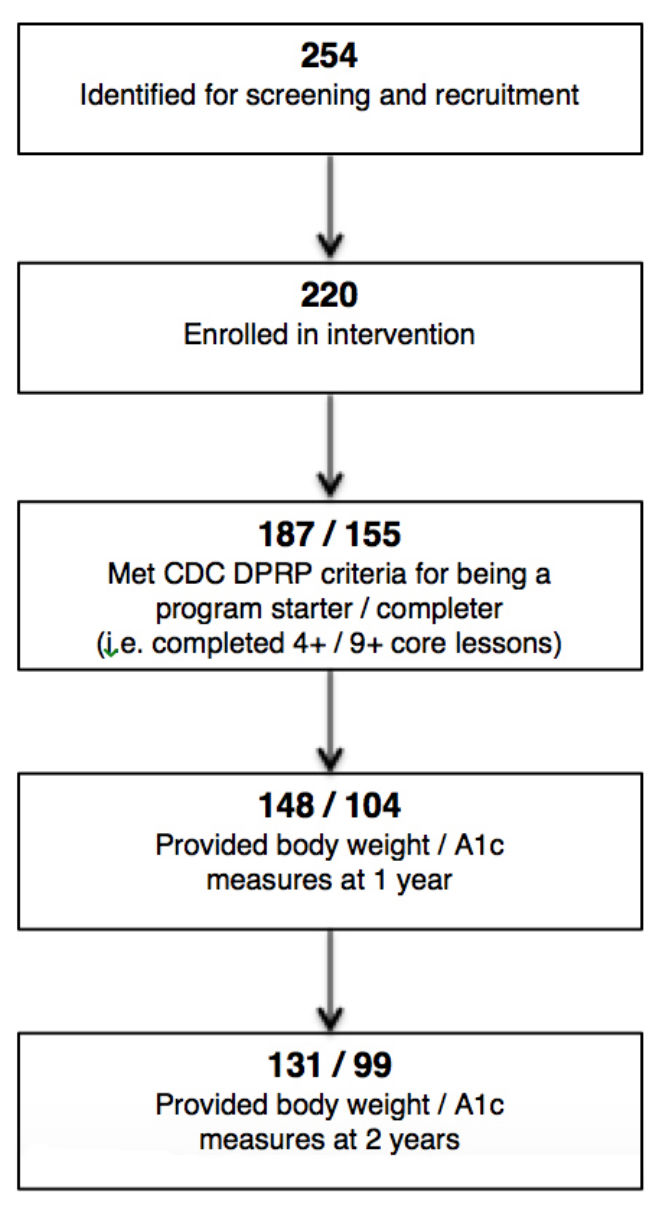
Figure 1. Participant recruitment and retention flow